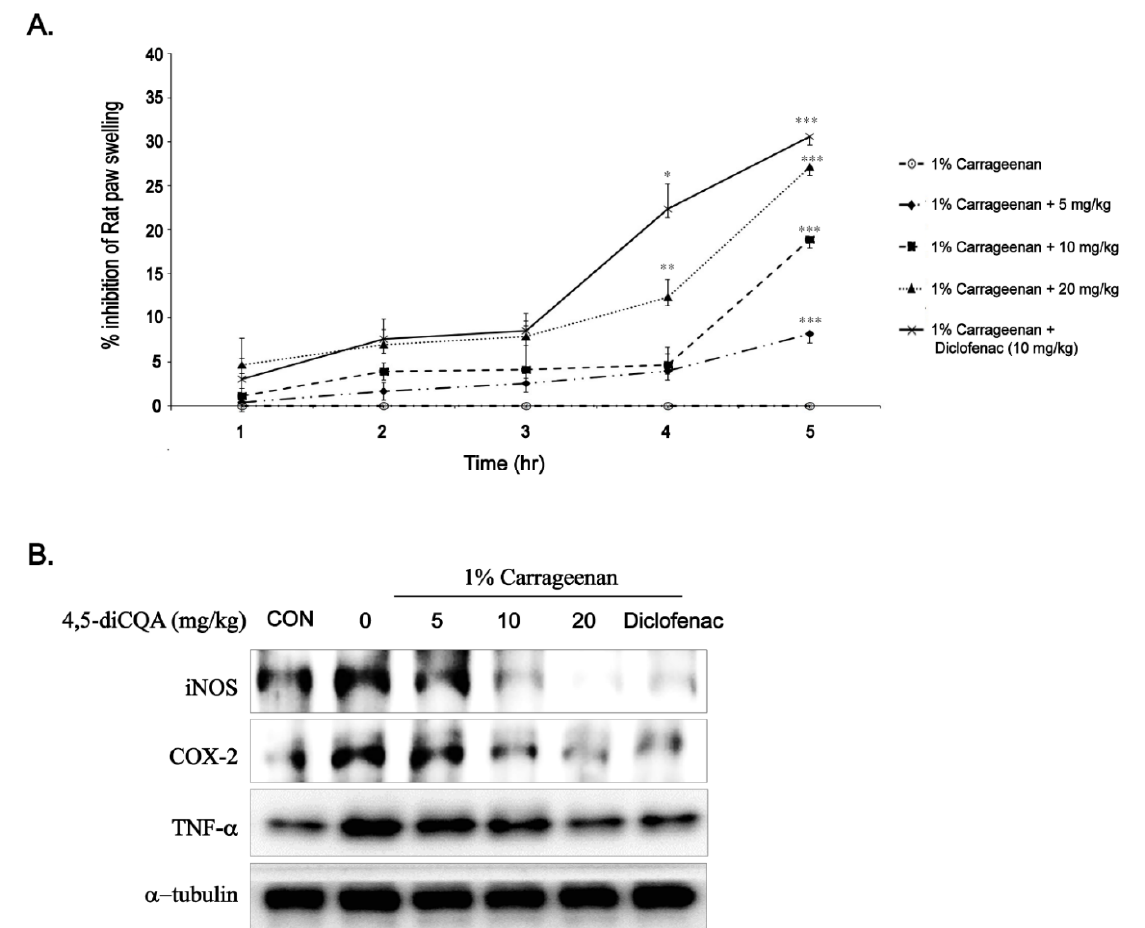
Figure 5. Effects of 4,5-diCQA on carrageenan-induced paw edema. Paw edema was induced by subcutaneous injection of a 1% carrageenan solution (100 µ L/animal) into the hind paw, 1 h after oral administration of 4,5-diCQA (5, 10, and 20 mg/kg) or diclofenac sodium (10 mg/kg). ( A ) Paw thickness was measured at 0–5 h after carrageenan injection. Results are the means ± SD of four animals. * p < 0.05, ** p < 0.01, and *** p < 0.001 compared to the carrageenan group at the corresponding time points. ( B ) At the end point, expression of iNOS, COX-2, and TNF- α in the spinal cord of experimental animals was determined using Western blot analysis. α -Tubulin served as an internal control. CON; control, iNOS; inducible nitrite oxide, COX-2; cyclooxygenase-2, TNF- α ; tumor necrosis factor-alpha.